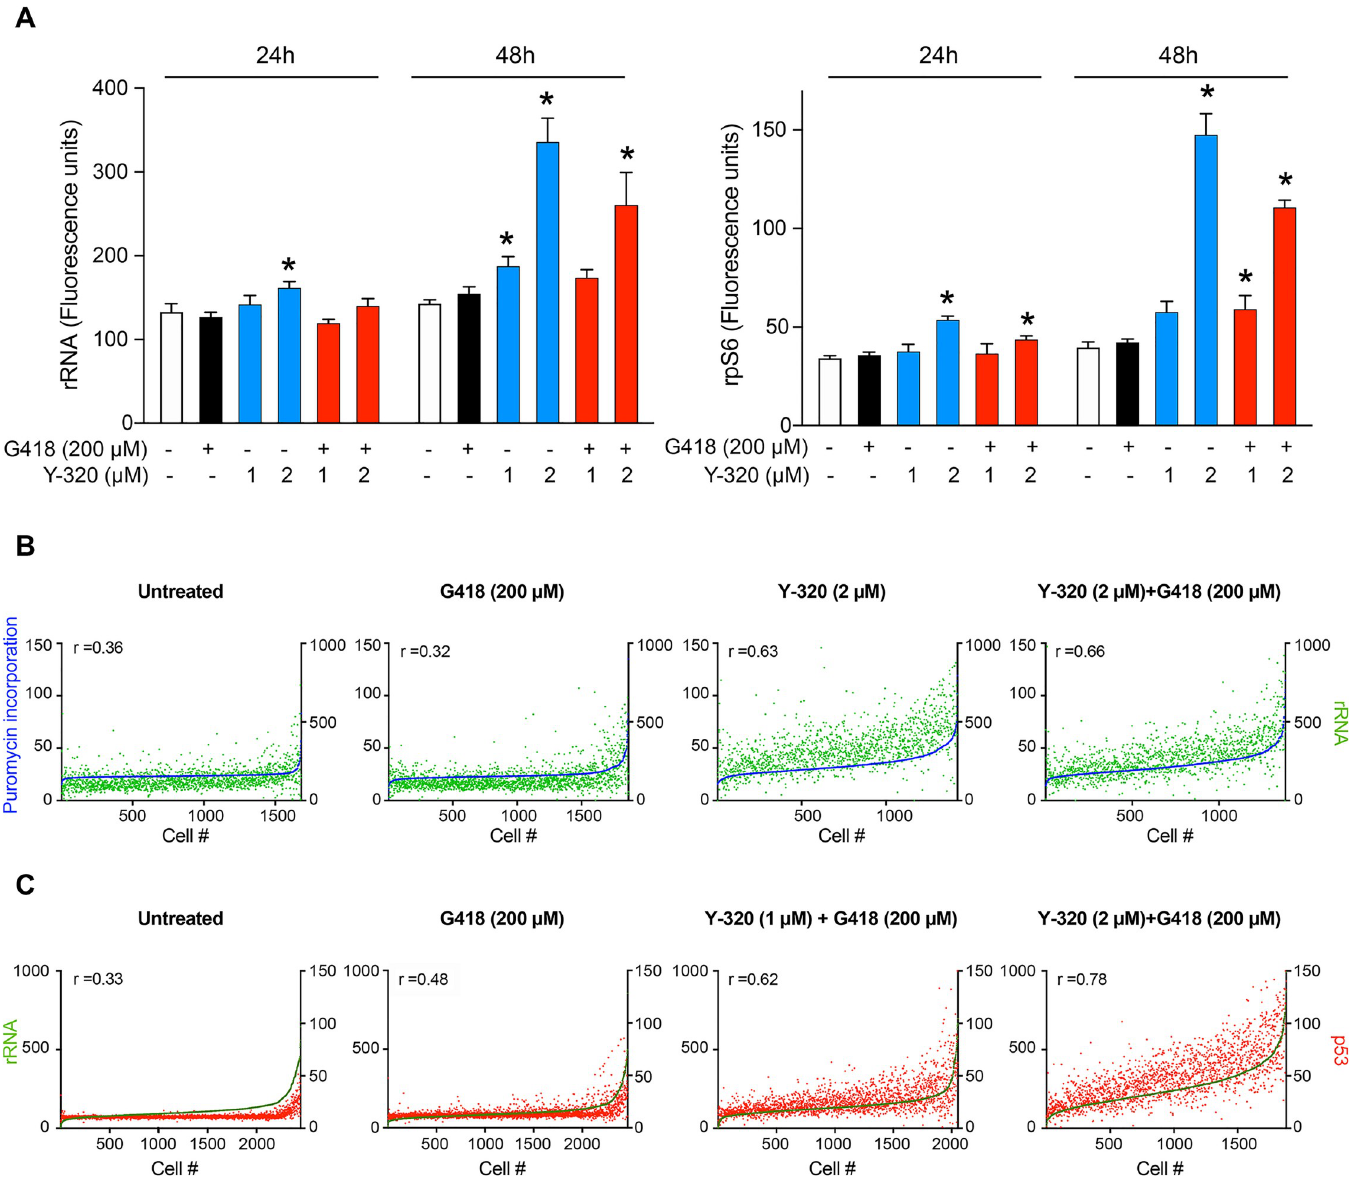
Fig 4. Stimulation of ribosome biogenesis by Y-320 and correlation with protein synthesis and p53 readthrough at the single cell level. (A) Ribosome biogenesis in HDQ-P1 cells. HDQ-P1 cells treated with the indicated compounds for 24 h and 48 h were fluorescently labeled using antibodies against rRNA and rpS6. Asterisks indicate values significantly different between treated and untreated cells ( p -value < 0.05; mean ± SD; n = 4). (B) Quantitation of puromycin and rRNA in single cells. HDQ-P1 cells treated with the indicated compounds were exposed to 2 μ g/ml harringtonine and 10 μ g/ml puromycin for 10 min. Antibody staining was carried out using anti-puromycin AF488 and anti-rRNA AF647 antibodies. The graphs are representative of each condition ( n = 4). Green dots (right y axis) represent rRNA expression and blue dots (left y axis) show puromycin labeling. Spearman coefficients (r) are shown in the graphs. (C) Quantitation of rRNA and p53 in single cells. HDQ-P1 cells treated with the indicated compounds for 48 h were fluorescently labeled using anti-rRNA AF647 and anti-p53 antibodies. The graphs are representative of each condition ( n = 4). Red dots (right y axis) represent nuclear p53 expression and green dots (left y axis) show rRNA expression. Spearman coefficients (r) are shown in the graphs. The numerical data underlying the plots can be found in S2